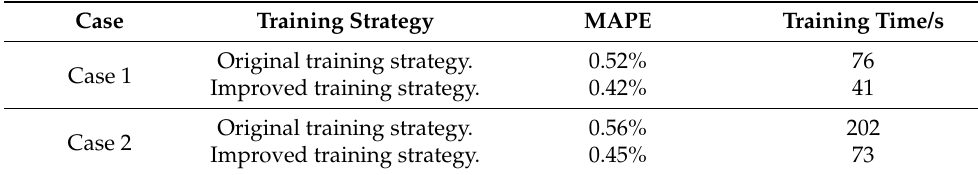
Table 6. The results of DBN-DNN model under different training